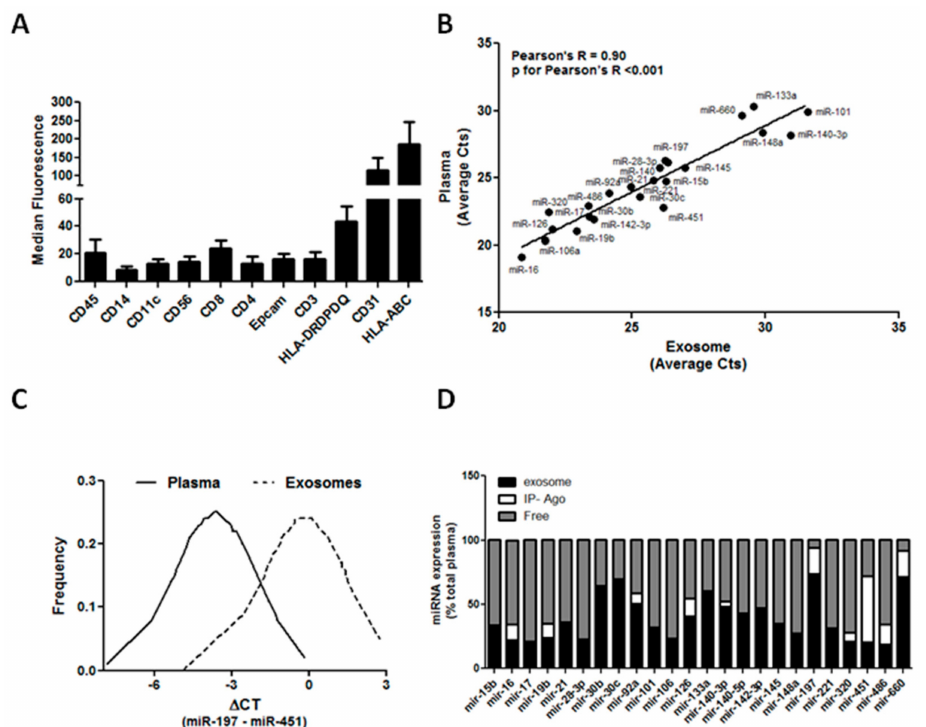
Figure 2. Exosomal miRNAs in the bioMILD trial. ( A ) Graphs show the surface markers on circulating exosomes in heavy smokers ( n = 5). ( B ) Correlation of miRNA levels in plasma and in exosomes ( n = 19 heavy-smokers volunteers and 8 lung cancer patients). ( C ) Normal distribution data for miR-197 and miR-451 in exosomes and plasma. ( D ) Physical status of circulating miRNAs in the plasma of heavy smokers ( n =